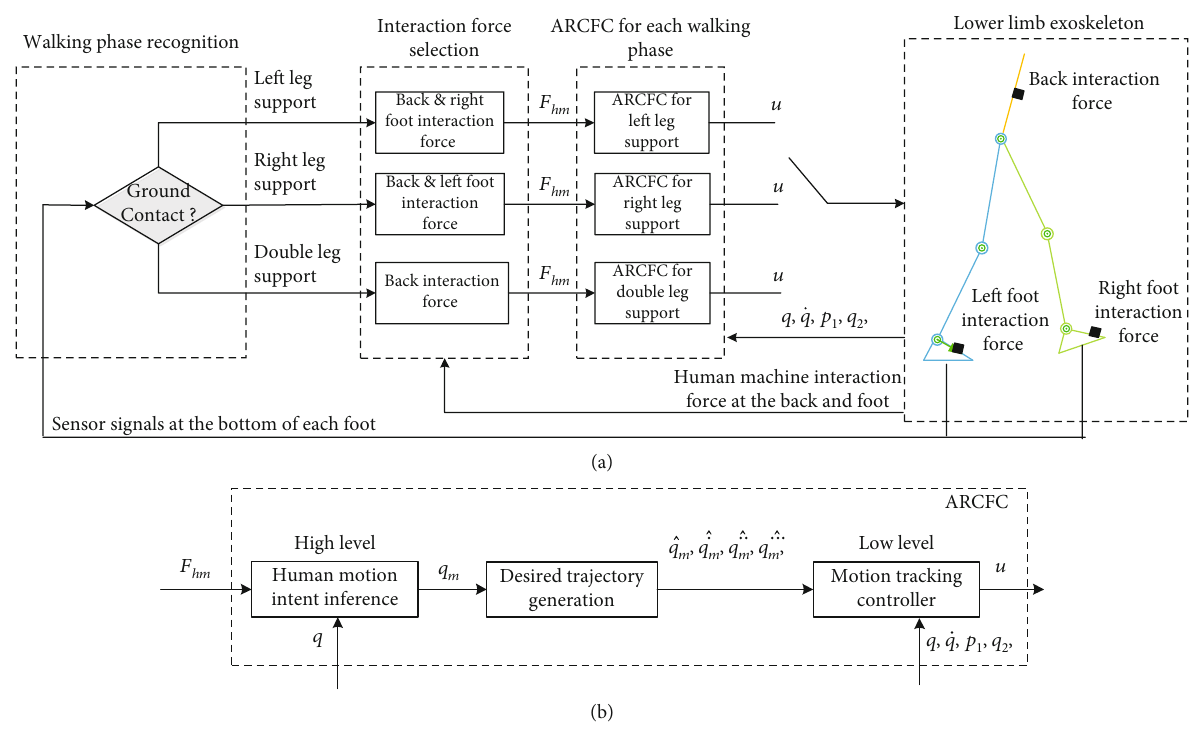
Figure 3: Control structure of the lower limb walking exoskeleton: (a) overall control structure and (b) structure of the adaptive robust cascade force controller (ARCFC).